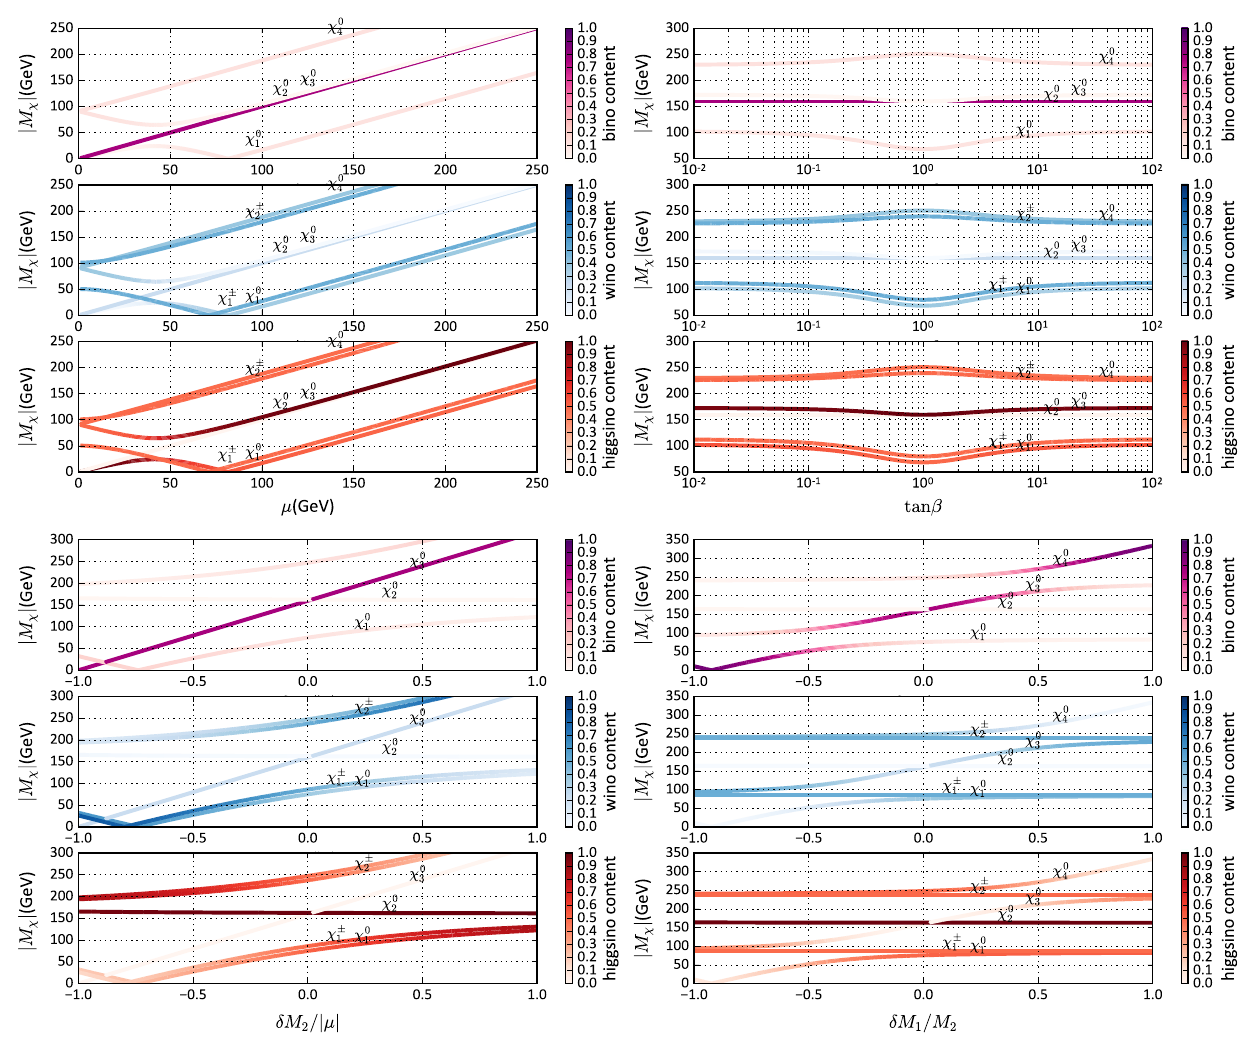
colour-coding (with increased line width for better visibility) indicates the bino (purple), wino (blue) and higgsino (red) content of the different